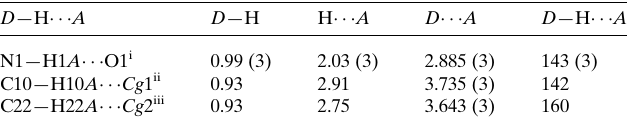
Table 1 Hydrogen-bond geometry (A˚ , (cid:2) ) for (I). Cg 1 and Cg 2 are the centroids of the C20–C25 and C1–C6 rings, respectively. D —H (cid:3)(cid:3)(cid:3) A